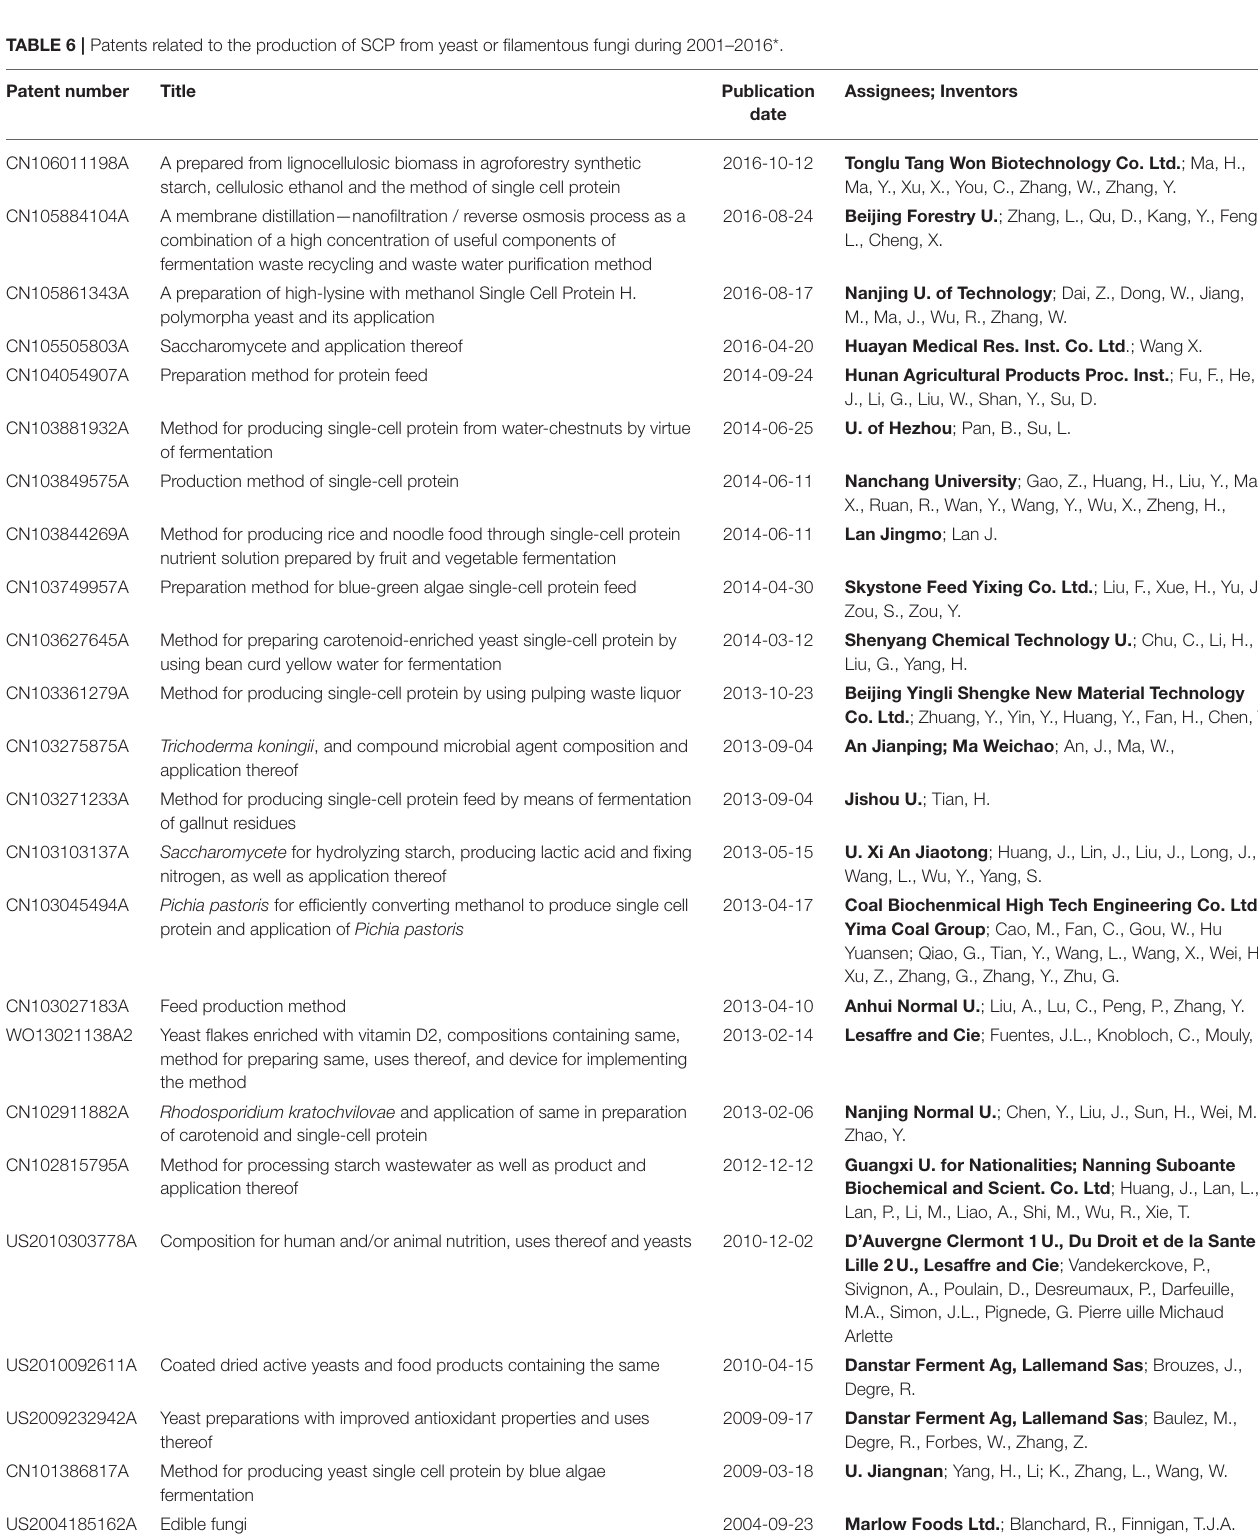
TABLE 6 | Patents related to the production of SCP from yeast or filamentous fungi during